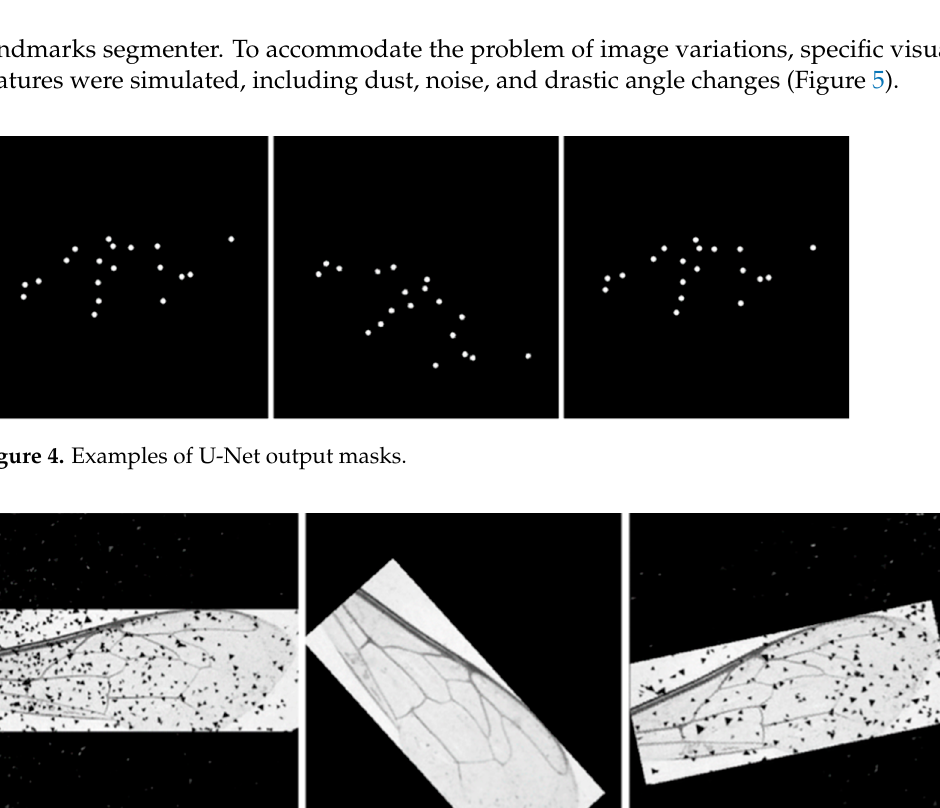
Figure 5. Examples of artificially created images to simulate visual variations.